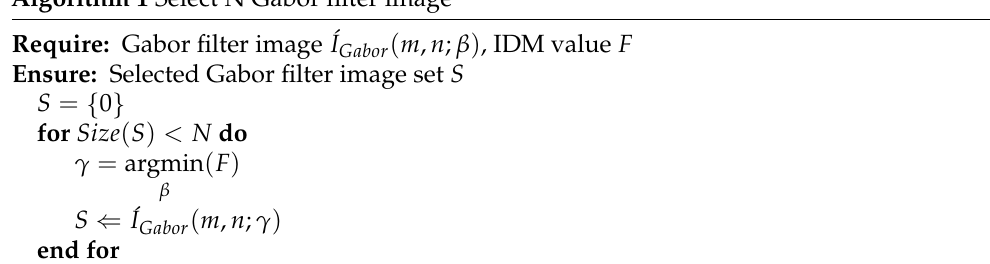
Figure 3. Gabor image according to phase in CCM stain image. ( a ) gray-scale inspection image; from ( b – i ) Gabor filter images according to phase. Algorithm 1 Select N Gabor filter